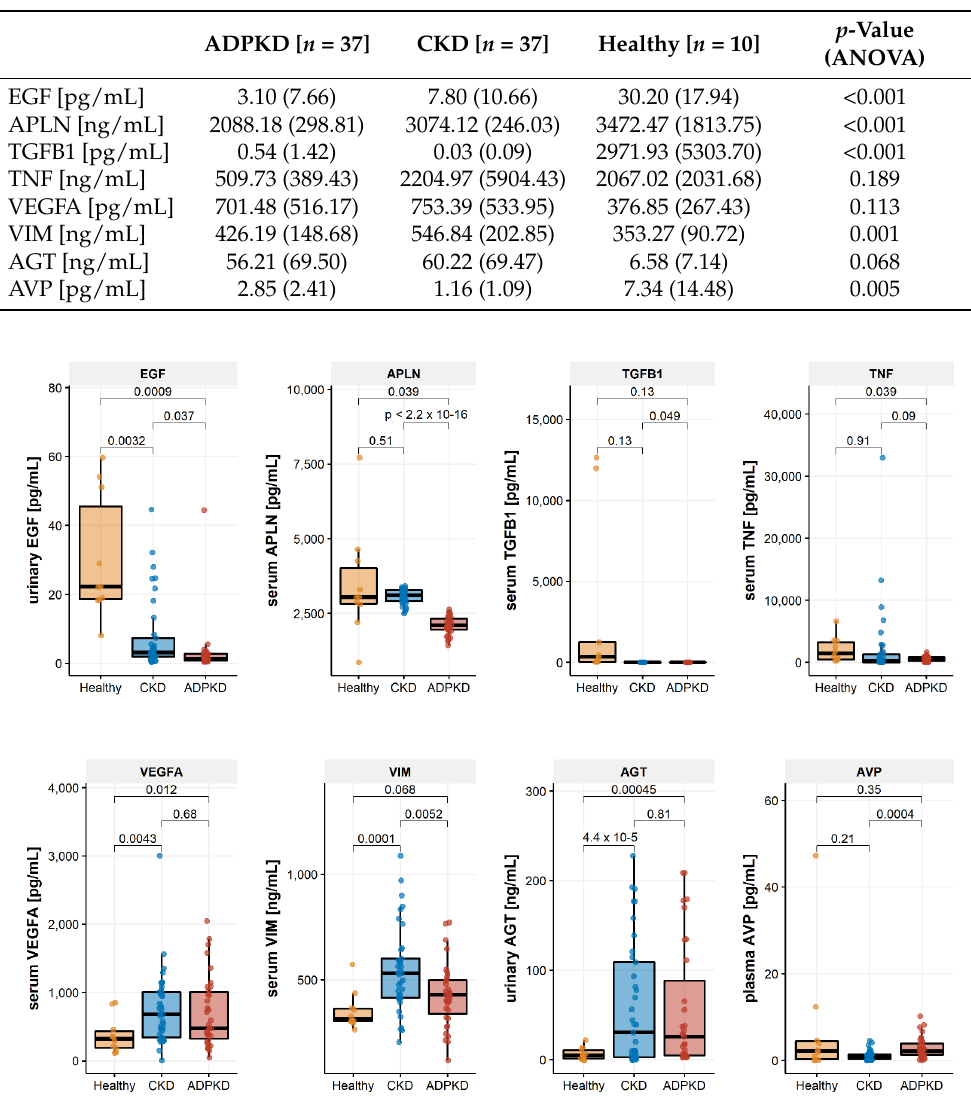
Figure 1. Protein concentrations of the eight investigated molecular biomarkers in the three studied cohorts. p -values are based on t -tests. cohorts. p -values are based on t